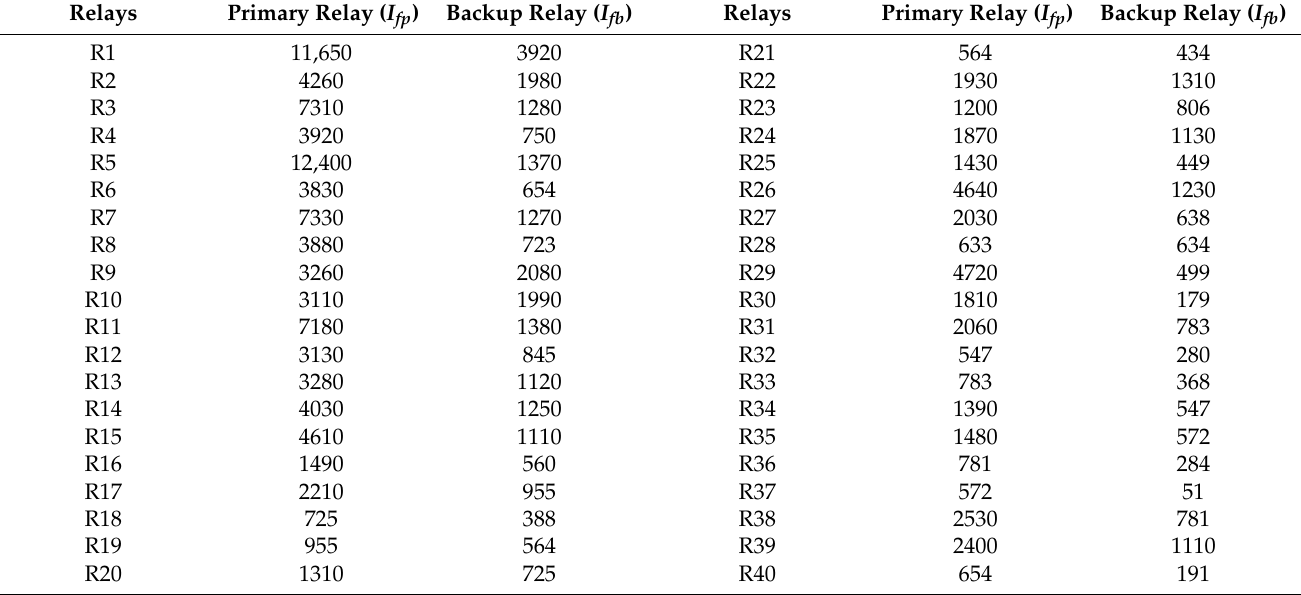
Table 8. Primary and backup relays fault currents of IEEE 14-bus system.